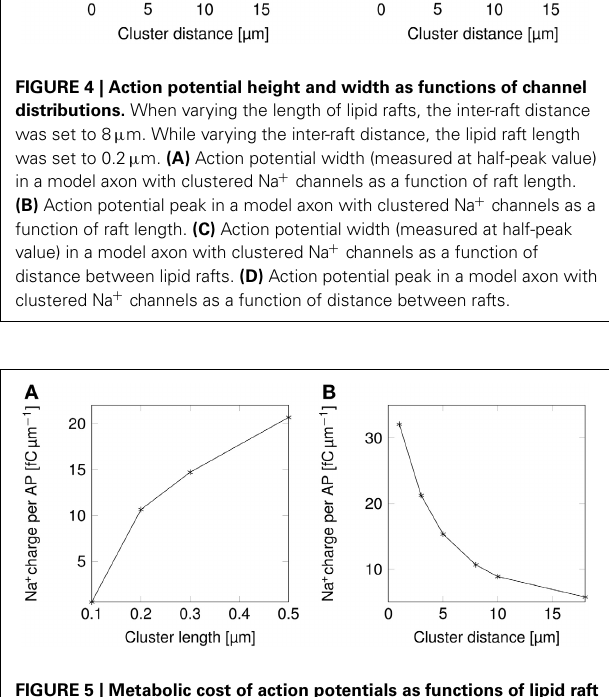
FIGURE 5 | Metabolic cost of action potentials as functions of lipid raft configuration in a 0.1 µ m diameter C-fiber axon. (A) Metabolic cost of action potentials in a model axon with clustered Na + channels for varying lipid rafts sizes. Distance between rafts was set to 8 µ m. (B) Metabolic cost of action potentials in a model axon with clustered Na + channels for varying inter-raft distances. Lipid raft length was set to 0.2 µ m.